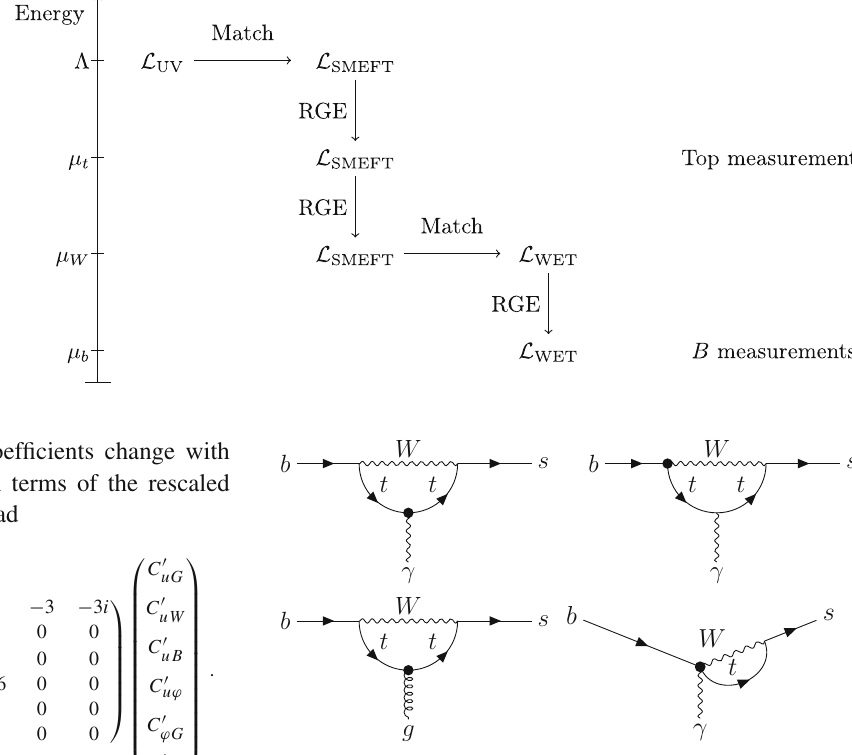
Fig. 3 Examples of one-loop diagrams for b → s γ and b → sg transitions. The black dots denote the insertion of a SMEFT